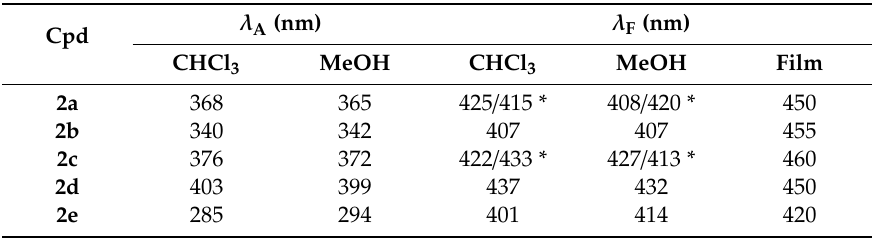
Table 2. Photophysical (absorption and luminescent) properties of the studied carboline derivatives 2a – 2e .